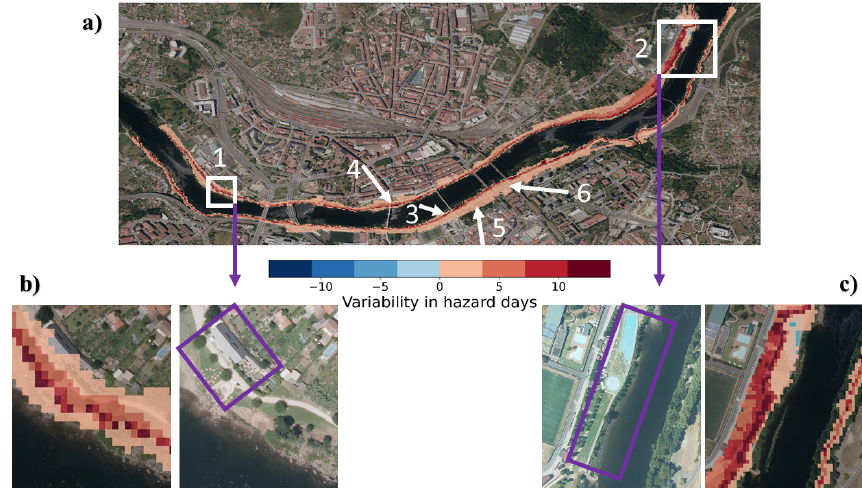
Figure 9. (a) Future variability in the number of days under hazard by floods in Ourense city. The increase (decrease) in the number of cases is obtained for each pixel of the domain by subtracting the number of days under flood hazard situation in the historical period from the number of hazard cases in the future period. Thus, red (blue) colors represent the increase (decrease) in the flood hazard considering the average of all models. Only the area outside the riverbed was taken into account for the flood risk analysis. In the lower panels two important areas of the city are shown in detail, (b) Chavasqueira thermal baths and (c) Oira park (aerial pictures courtesy of PNOA © Instituto Geográfico